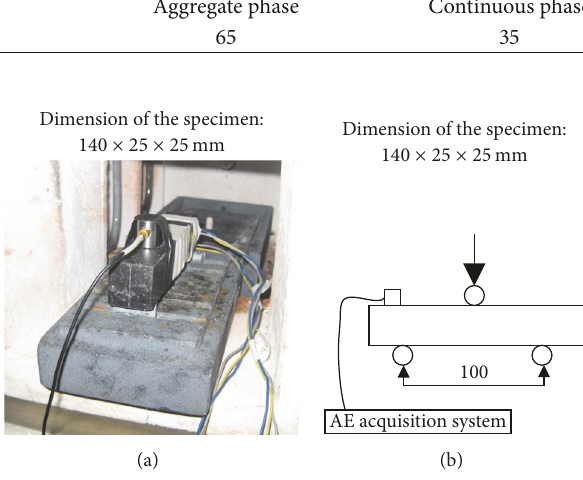
Figure 2: Experimental setup for three-point bend test at room temperature. (a) The physical diagram and (b) the schematic one. The AE sensor is fixed on the specimen through the adhesive tape. The pressure actuating pressure head is imposed on the middle of the specimen.